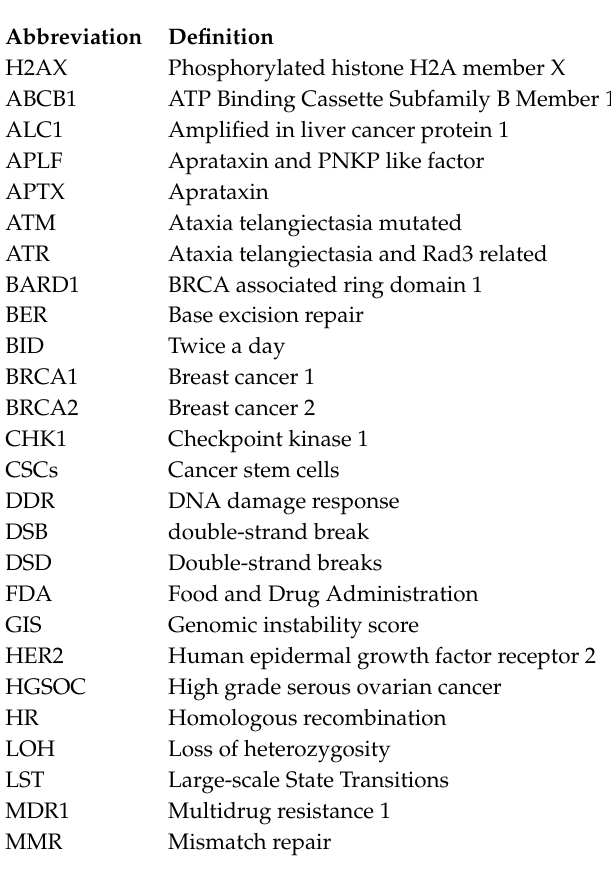
Table S1: Genes with full coding exonic regions in FoundationOneCDx for the detection of substitutions, insertions and deletions, and copy number alterations, Table S2: Genes with select intronic regions for the detection of gene